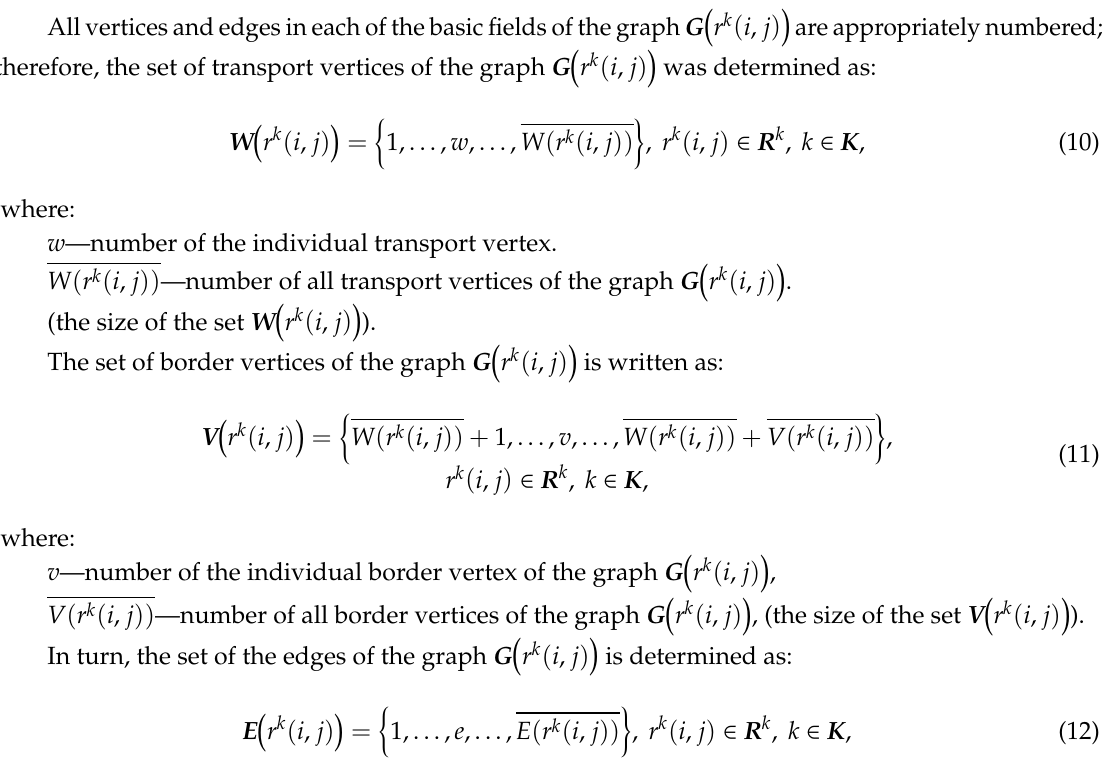
Figure 2. Construction of the graph of the road and street network for a single basic